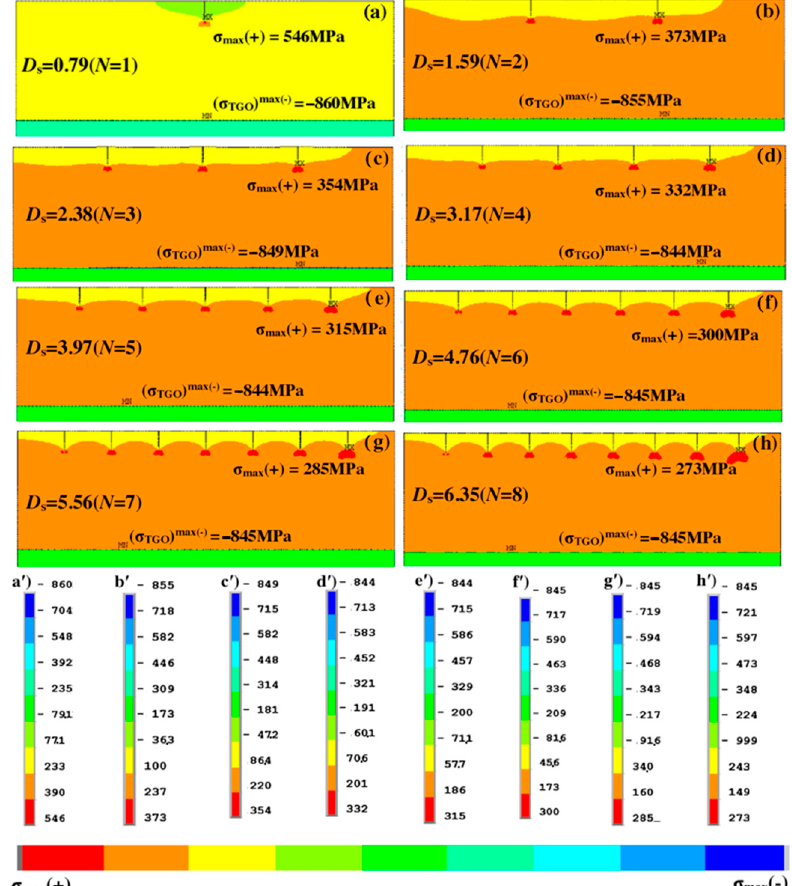
Figure 28. Radial stress distribution of TTBCs with different segmentation crack densities [158] . ( a ) 0.79 mm − 1 crack density; ( b ) 1.59 mm − 1 crack density; ( c ) 2.38 mm − 1 crack density; ( d ) 3.17 mm − 1 crack density; ( e ) 3.97 mm − 1 crack density; ( f ) 4.76 mm − 1 crack density; ( g ) 5.56 mm − 1 crack density; ( h ) 6.35 mm − 1 crack density, ( a ʹ – h ʹ ) shows the scalar of the contour of the corresponding figures ( a – d ) (unit: MPa).